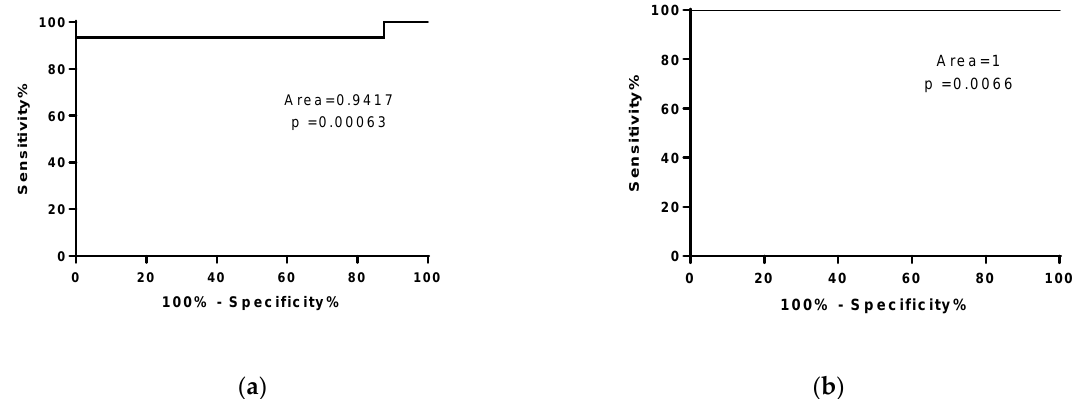
Figure 4. MiR-206 is a biomarker for symptomatic ALS mice. ROC curve analysis of miR-206 levels in WT mice compared to ( a ) SOD1 G93A high-copy mice at end stage and ( b ) SOD1 G93A low-copy mice at late stage of the disease.